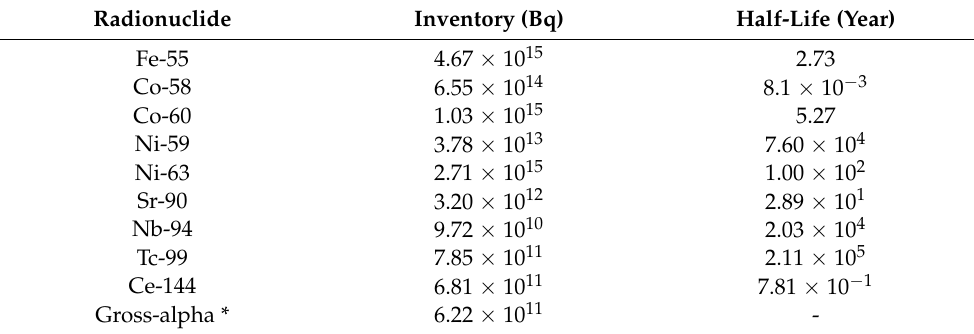
Table 1. Radionuclide inventories employed in the present work taken from the literature